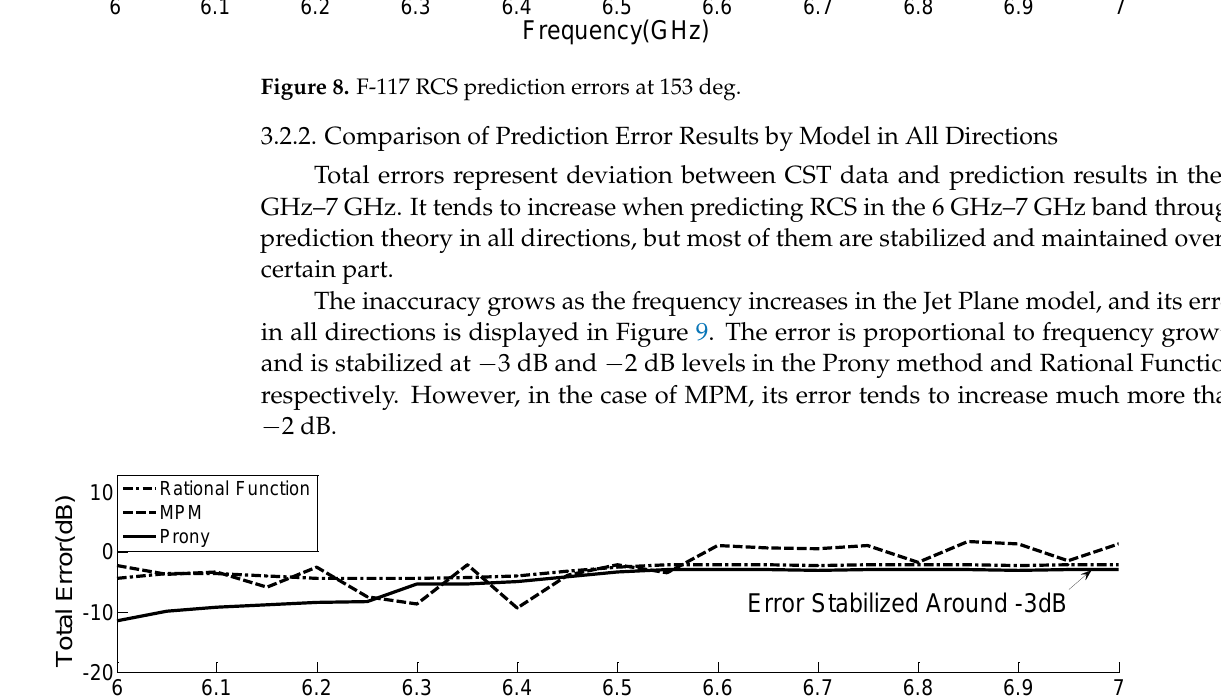
Figure 10. Transport Plane Prediction error results in all directions.